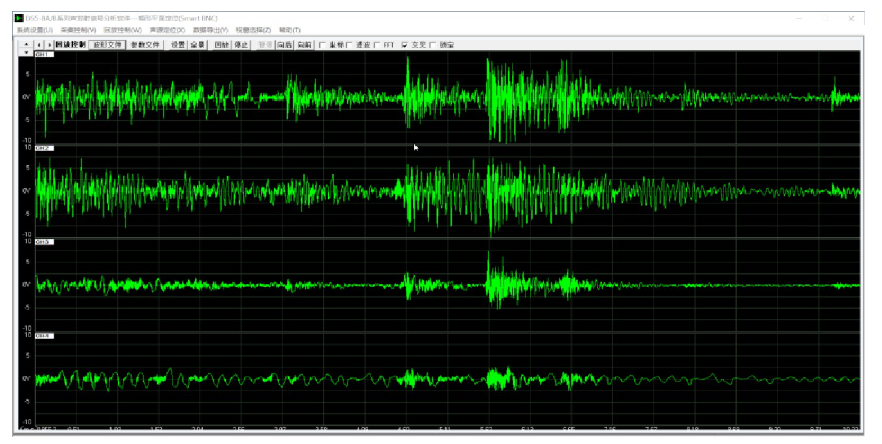
Fig 3. Typical acoustic emission burst signal.